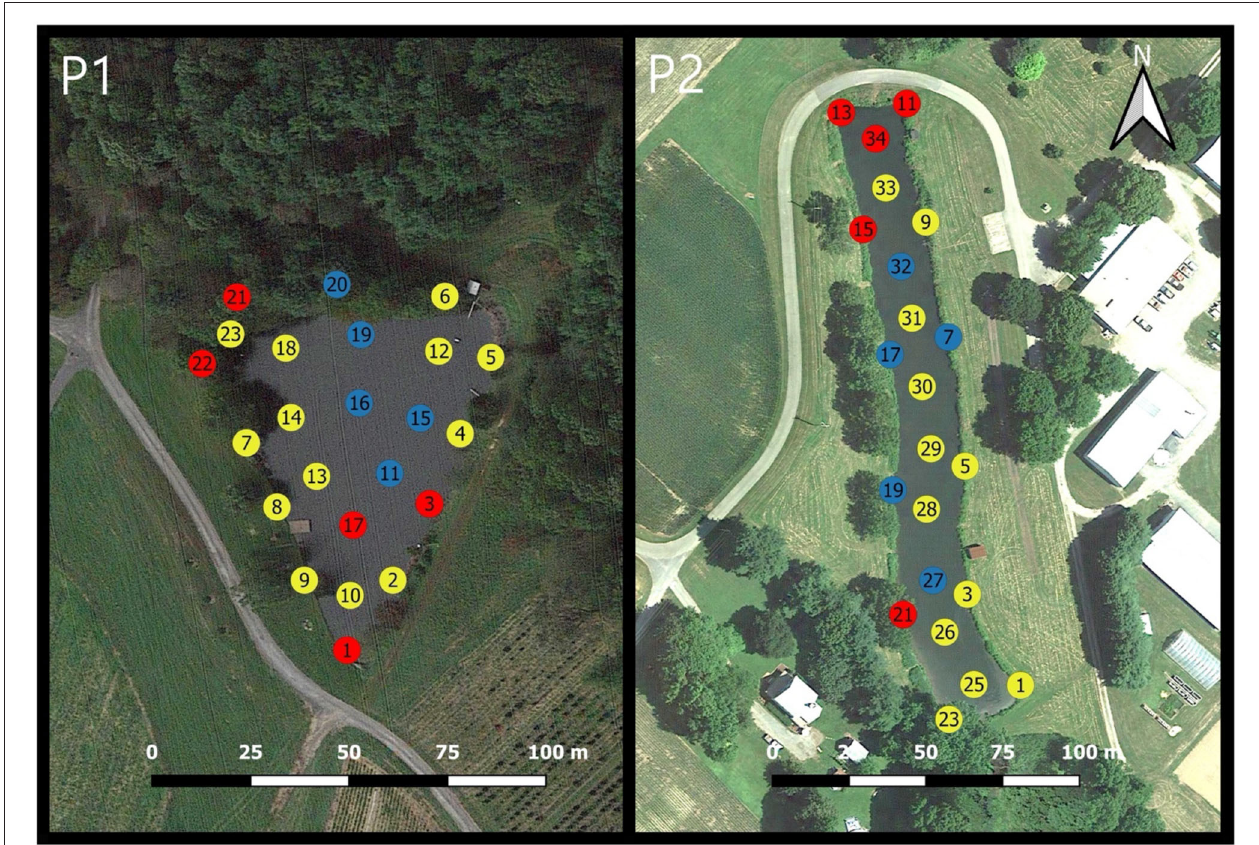
FIGURE 6 | Mean relative differences (MRD) of cyanobacteria over the 2-year period for Pond 1 (P1) and Pond 2 (P2). Locations with MRD values below the 25th percentile are displayed in blue, locations above the 75th percentile are displayed in red and locations between the 25 and 75th percentile are displayed in